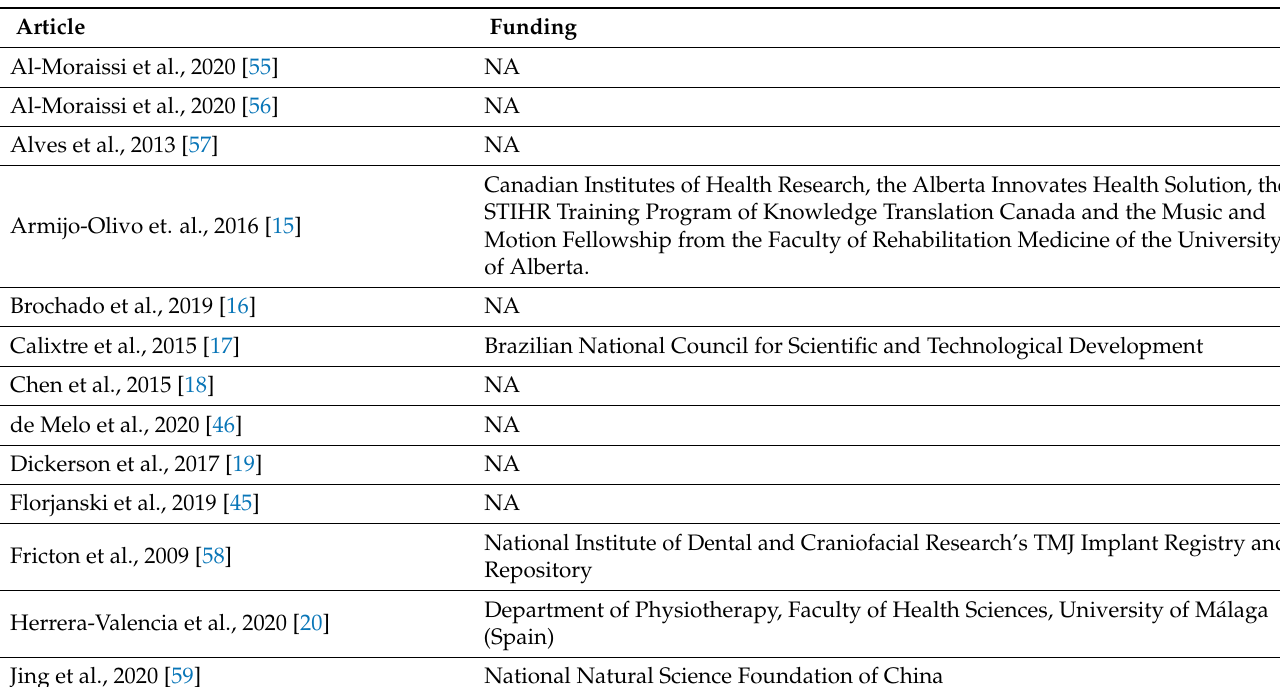
Table A3. Funding information of included systematic